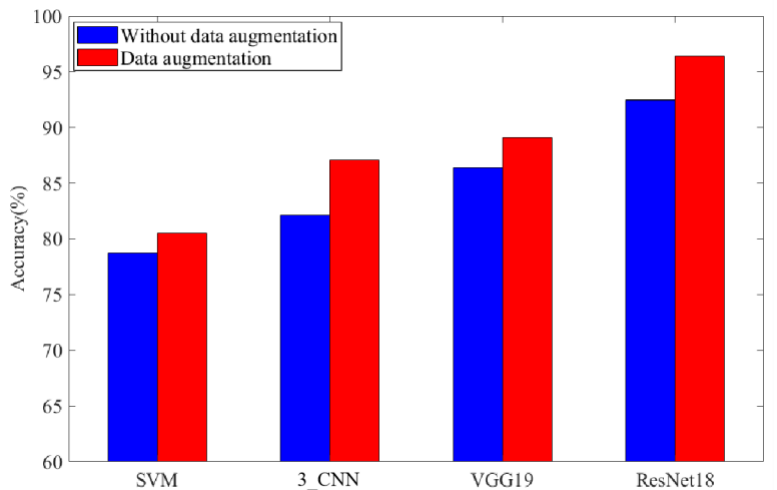
Figure 16. Comparison of recognition accuracy with the input of the MFCC using data augmentation technology and not using data augmentation technology.